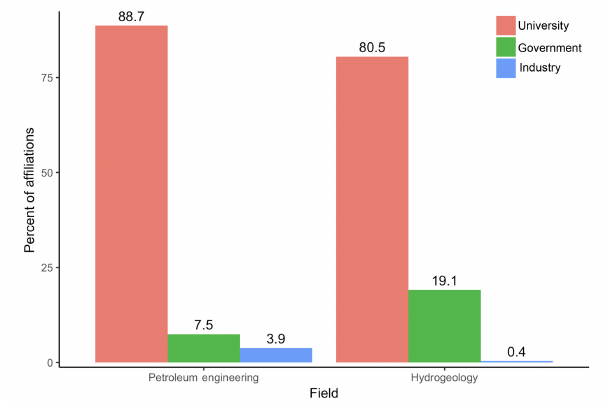
Figure 1. Bibliometric survey results for university, government, and industry author affiliations for petroleum engineering (left) and hydrogeology (right). The numbers on top of the columns indicate the percent of affiliations per category. The percent of affiliations reflect the proportion of total unique affiliations per document re- turned by the Web of Science database for each category (see Ap- pendix A for full survey details). The total unique affiliation is a weighted sum of unique affiliations returned by the Web of Science with weights being the number of documents containing that affili- ation at least once; i.e., two authors from the same institution on the same document are only counted